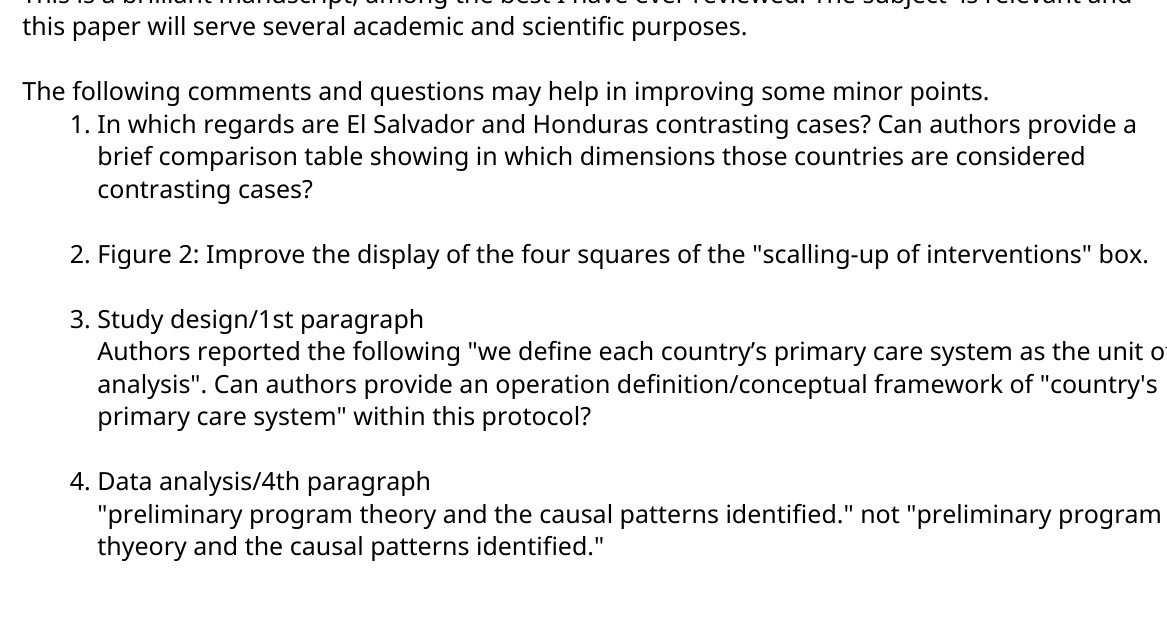
Figure 2: Improve the display of the four squares of the "scalling-up of interventions" box.